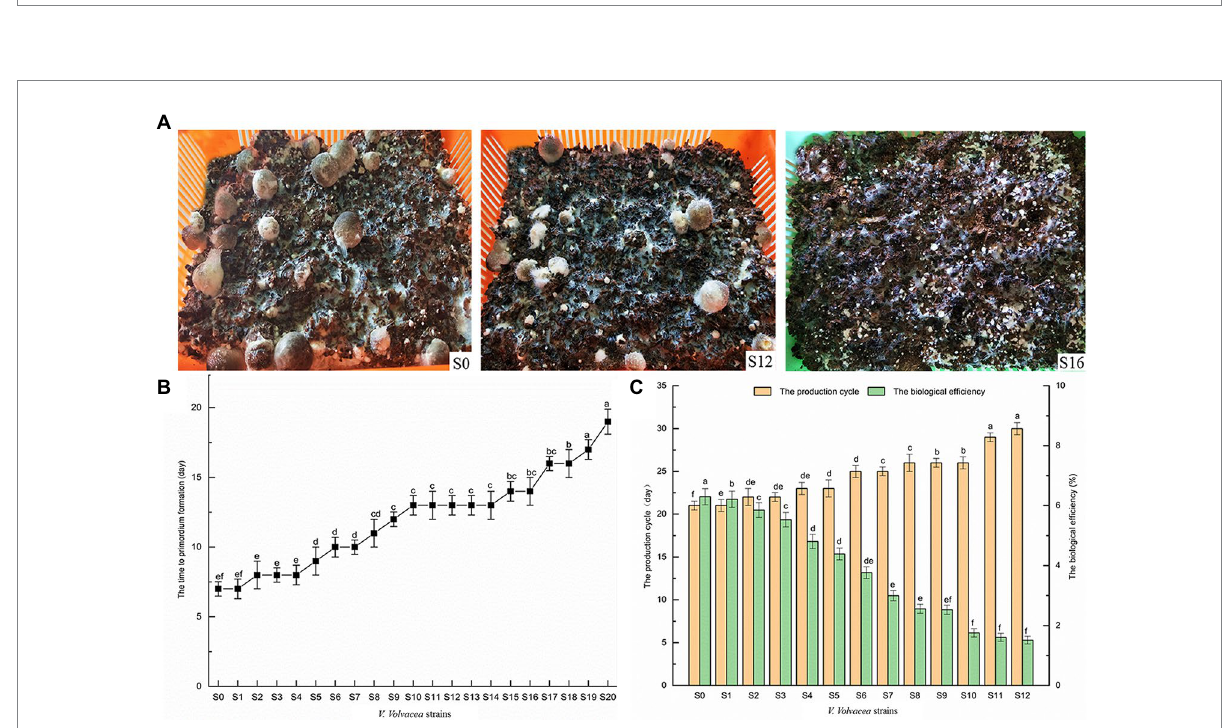
FIGURE 2 Production traits of Volvariella volvacea subcultured strains (A) Changes in the characteristics of the fruiting bodies (the volume of the plastic frames was 30 cm × 22 cm × 10 cm). (B) The time to primordium formation. (C) The production cycle and the biological efficiency of the fruiting bodies. Values represent the mean of three measurements ( n = 3), while vertical bars represent the standard deviation; different letters indicate significantly different values ( p <